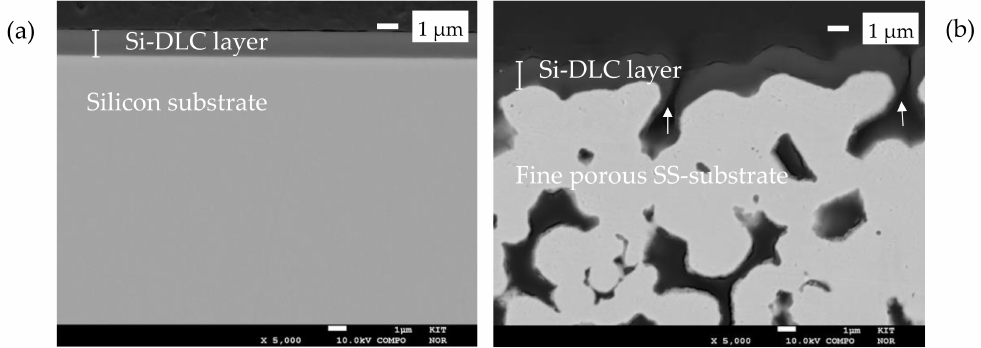
Figure 5. SEM Image of the cross-section of the Si-DLC coating on ( a ) a flat silicon substrate and ( b ) a fine porous SS